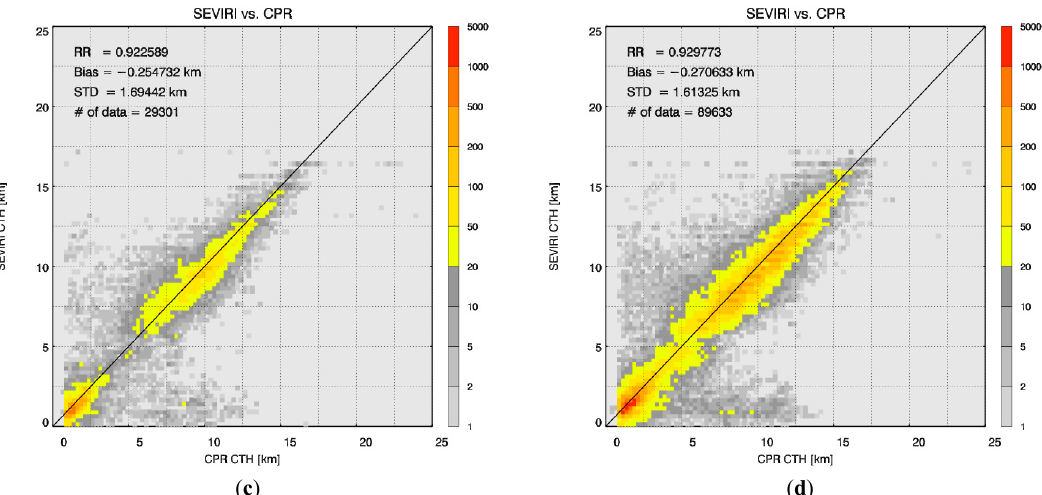
Figure 7. Spinning Enhanced Visible and Infrared Imager (SEVIRI) cloud-top height (CTH) scatter plots compared with Cloud Profiling Radar (CPR) CTH for each period used a different CO 2 bias correction increment. The periods and CO 2 increment values are ( a ) 1 May–26 June 2013, CO 2 BC: